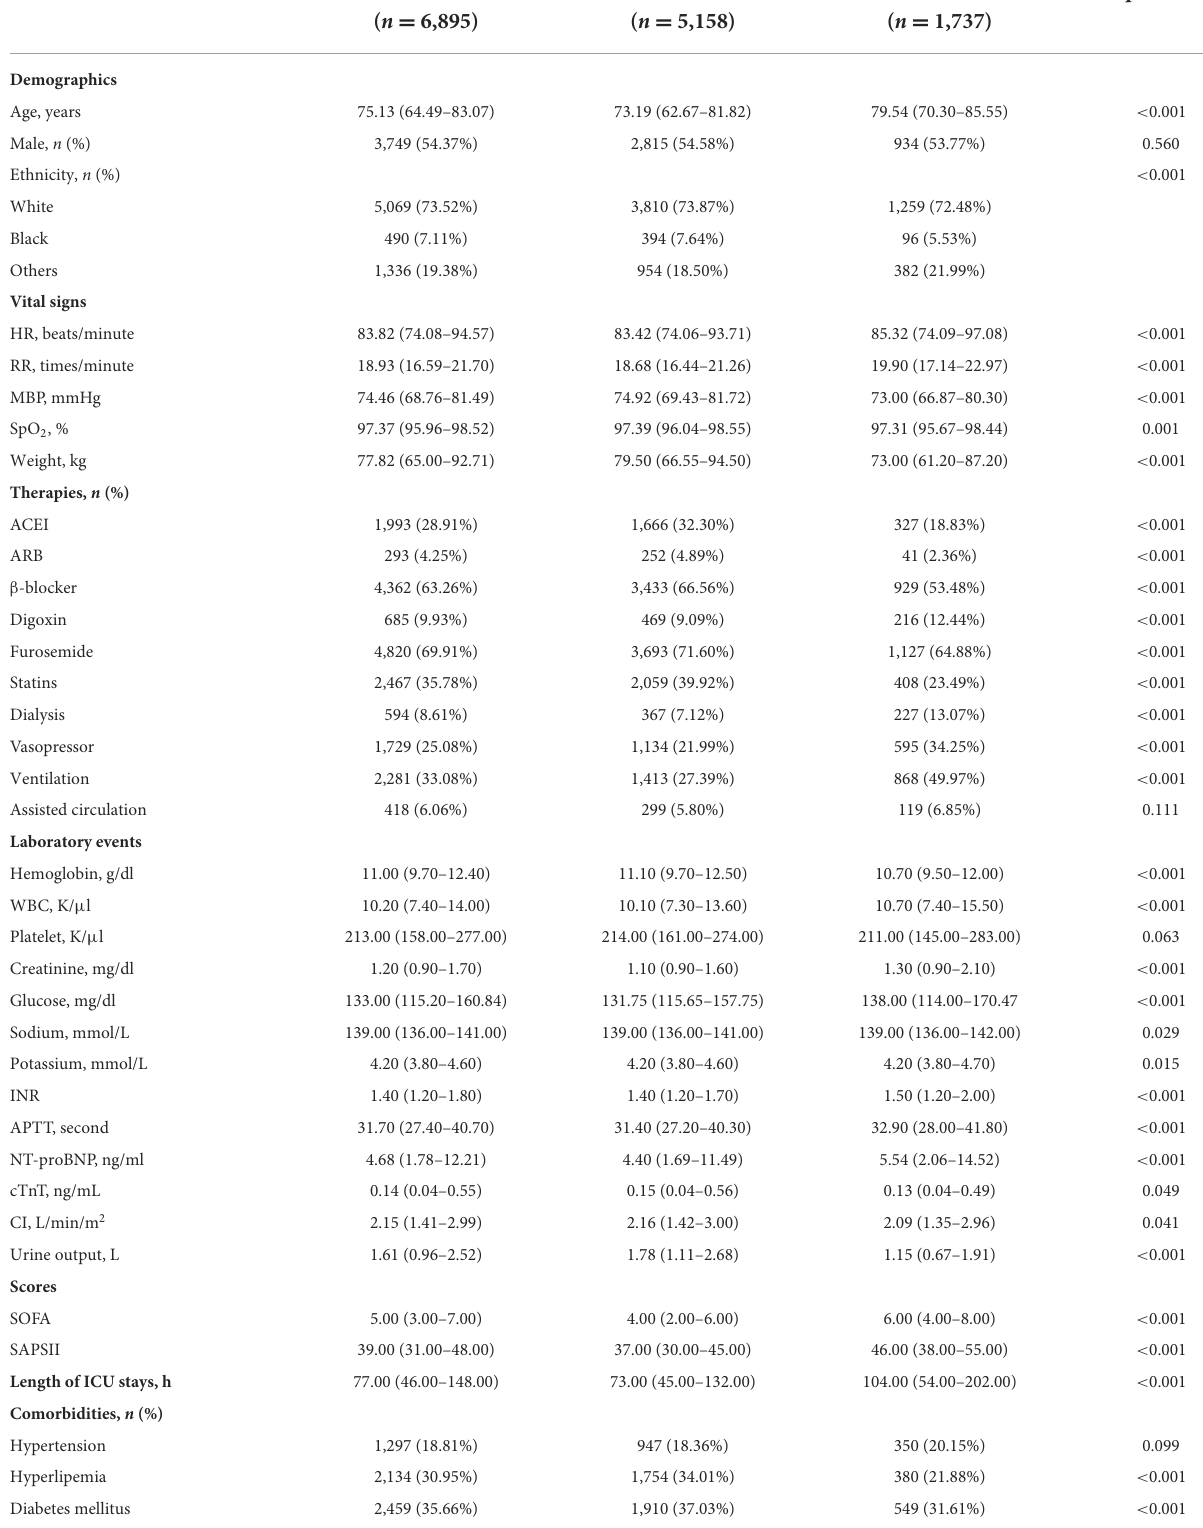
TABLE 1 Comparison of baseline data between survivor and non-survivor